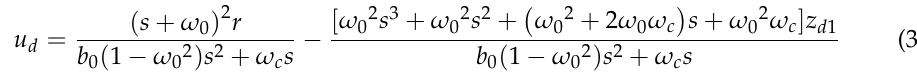
Figure 5. BS-LADRC controller structure of internal-loop and external-loop control coupling.